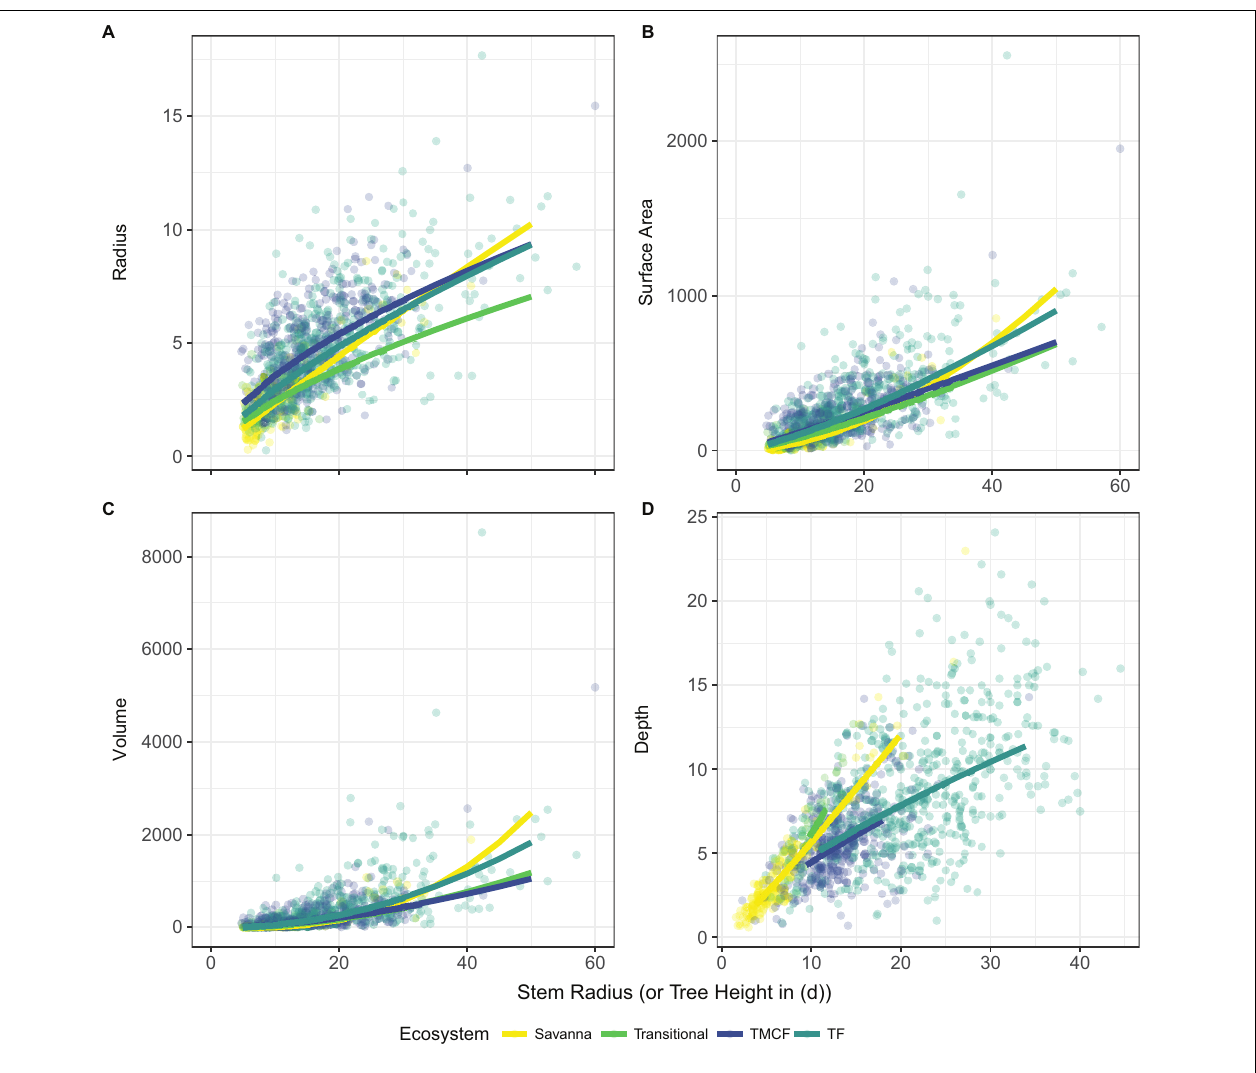
FIGURE 7 | LMM predictions (lines) and individual trees (points) across all regions, grouped by ecosystem type. The crown depth model includes both stem radius and tree height, and is plotted against tree height. For predictions, ecosystem-specific DBH-height allometries were constructed and